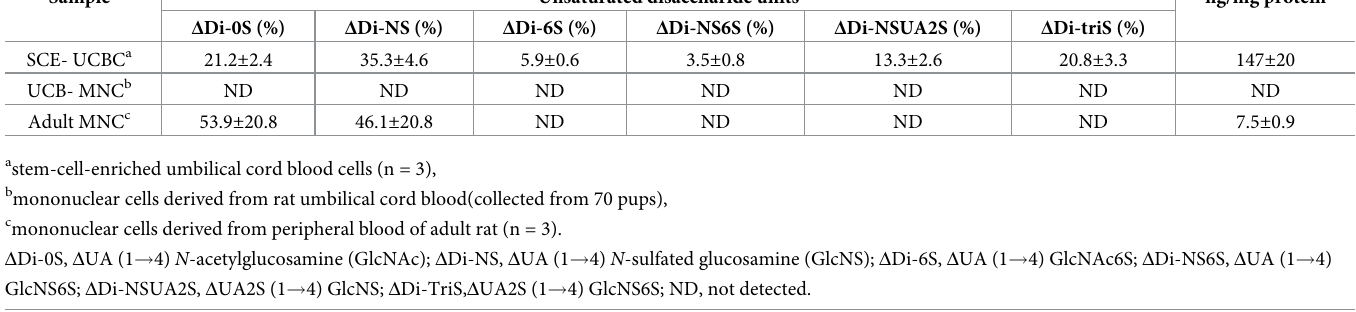
Table 3. Disaccharide composition of HS in GAG from UCBCs and MNCs. Sample